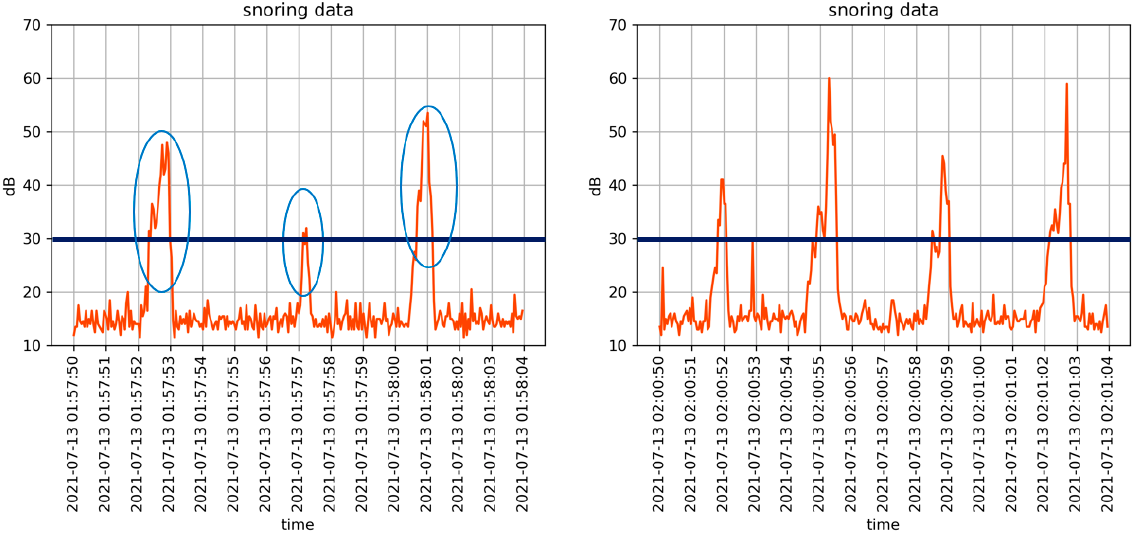
Figure 15. Sound detection of snoring interval (15 s): 01:57:50 a.m. to 01:58:05 a.m. ( left ) and 02:00:50 a.m. to 02:01:05 a.m. ( right ).